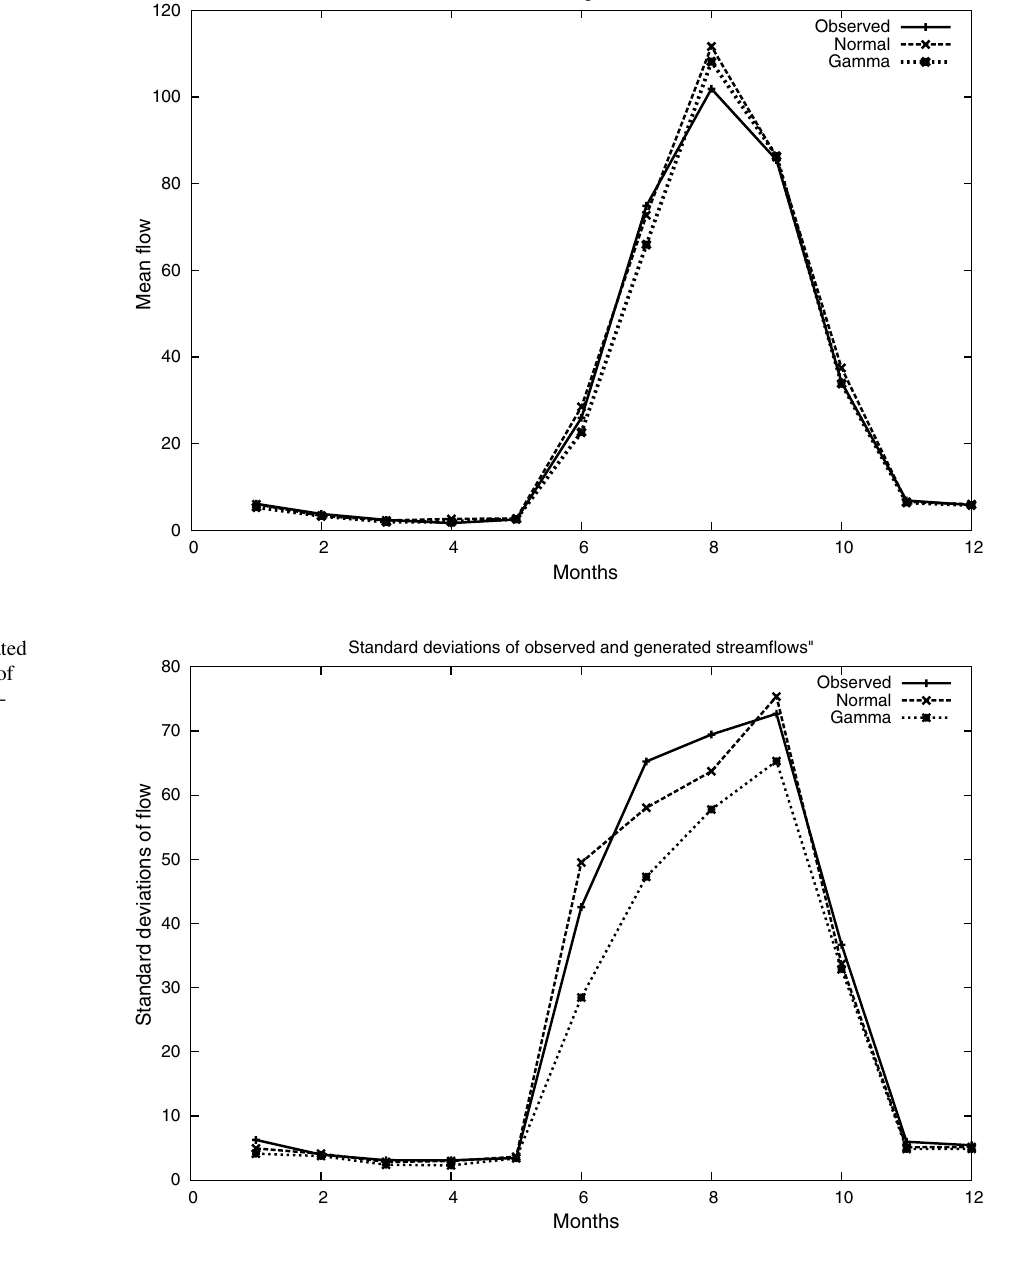
Fig. 15 Historical and gener- ated monthly means of flows in Barakar River (multi-site model)